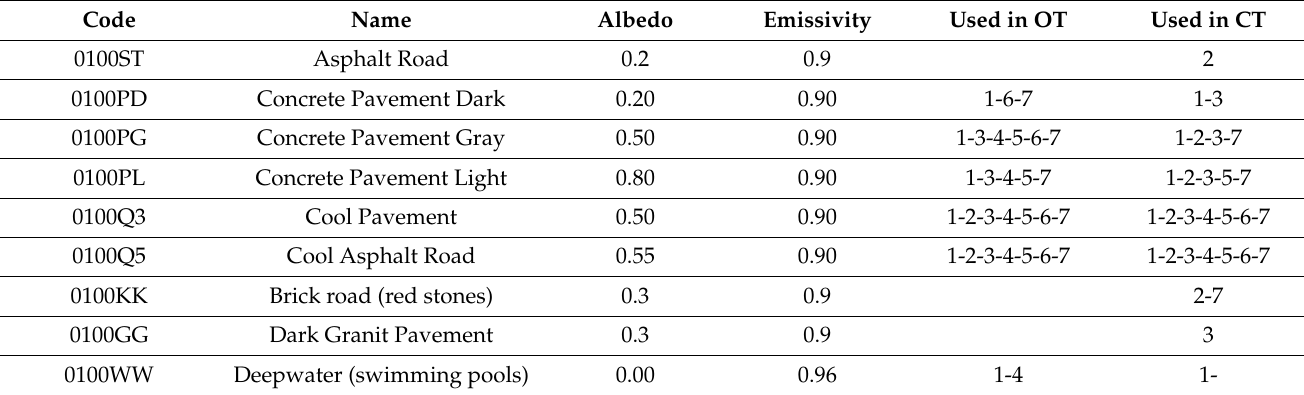
Table 5. The urban surfaces albedo and